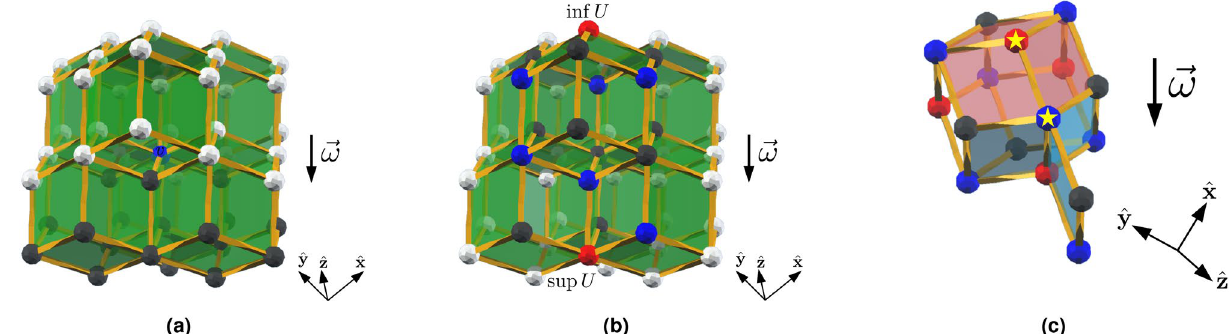
Figure 3. The sweep rule in the rhombic dodecahedral lattice. The sweep direction � ω = − ( 1, 1, 1 ) is indicated by the arrow. ( a ) The future ↑ ( v ) of v (the blue vertex), is the power set of the black vertices and the blue vertex. ( b ) The causal diamond of U , where U is the set of blue vertices. The red vertices are sup U and inf U , and ♦ ( U ) is the power set of the red, black and blue vertices. ( c ) In the rhombic dodecahedral lattice, there are two types of vertices: one type is degree four (red and black) and the other is degree eight (blue). The red (blue) shaded faces are the qubits that the rule may return, depending on the syndrome at the highlighted red (blue) vertex. The rule returns nothing at the black vertices because there are no syndromes whose restriction to a black vertex is in the future of that